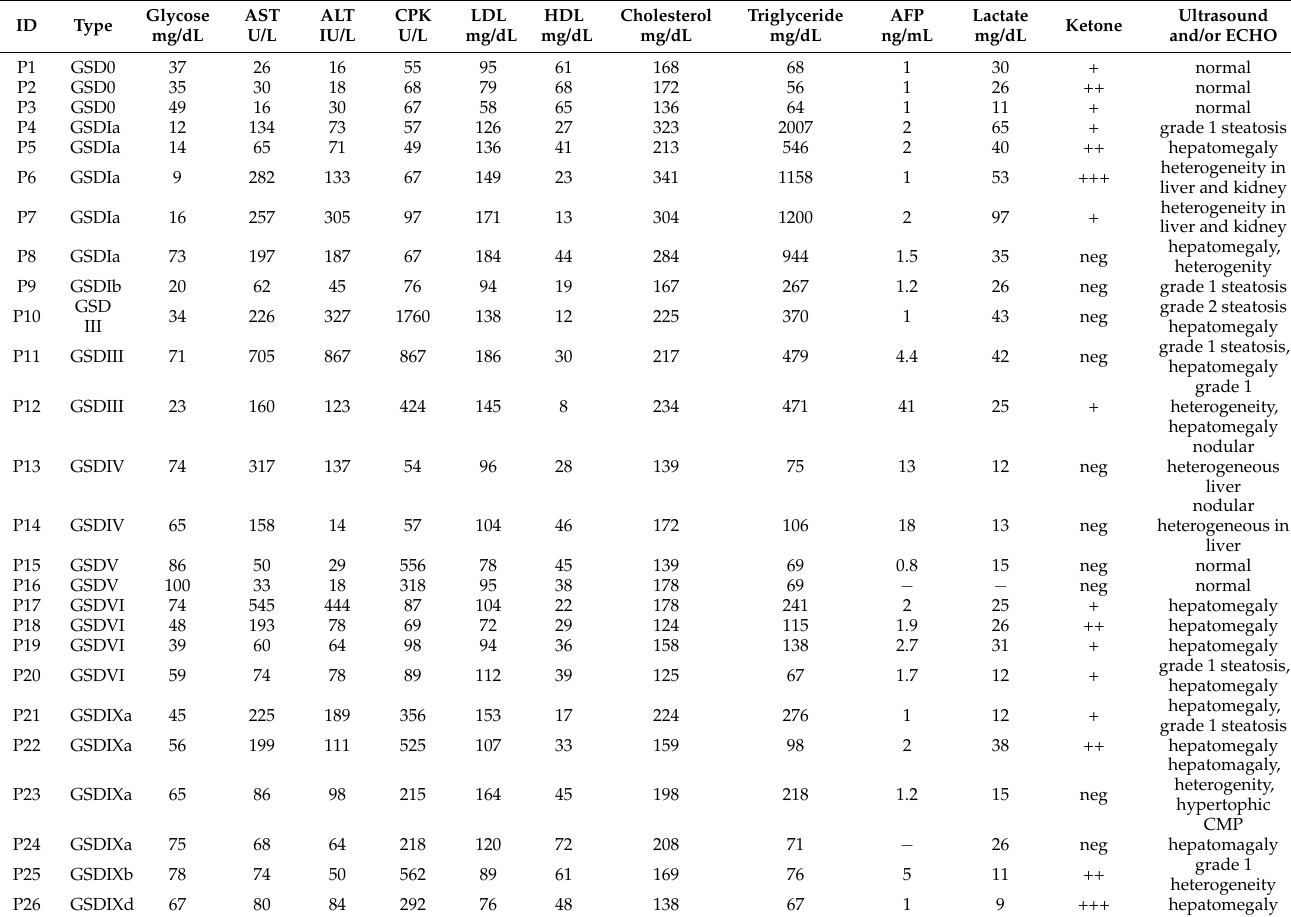
Table 2. Initial laboratory and imaging features of